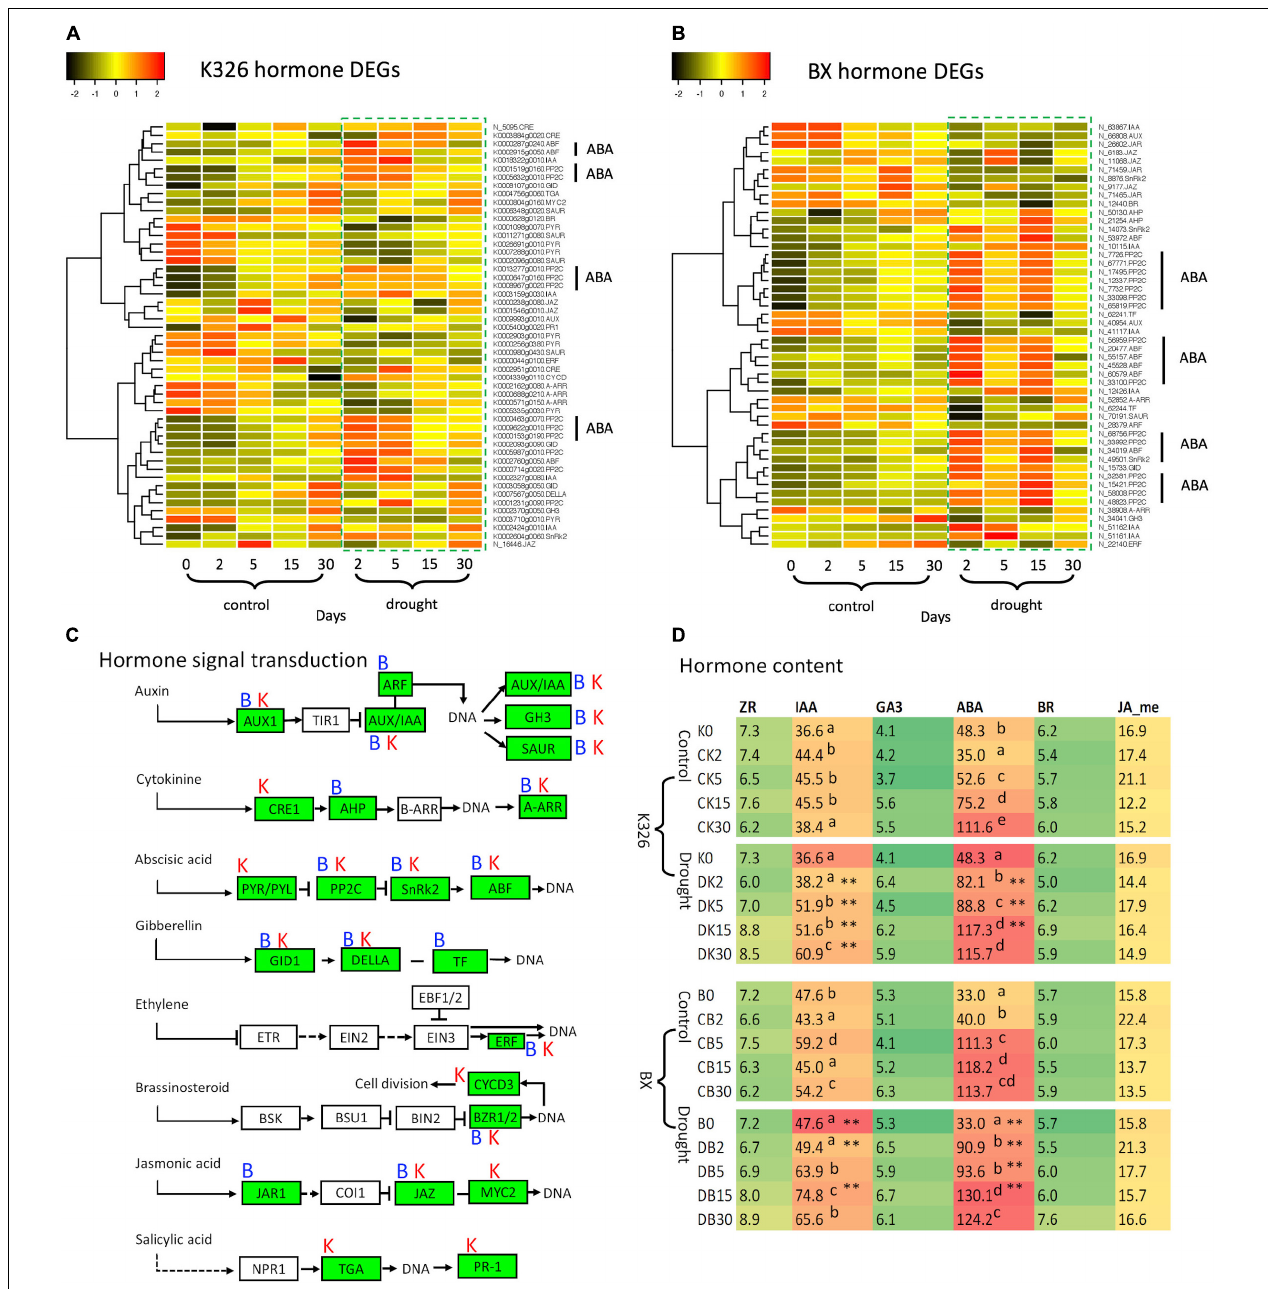
FIGURE 3 | Comparison of hormones and DEGs in hormone signaling pathways under drought stress. (A) Patterns of DEG expression level after log 2 (FPKM + 1) transformation and Z -score scaling in variety N. tabacum K326. (B) Patterns of DEG expression level after log 2 (FPKM + 1) transformation and Z -score scaling in variety N. tabacum BX. (C) Hormone signal transduction pathways, which were drawn based on the information of module ko04075 in the KEGG database (https://www.genome.jp/kegg, accessed on November 18, 2019); Letters “B” and “K” represent the DEG presence at BX and K326, respectively. (D) Abundances of six hormones. The hormone content was calculated as ng per gram of fresh leaves. Up script letters denote the significant differences from Duncan’s multiple range tests with p < 0.05. Asterisk ** represents significance at p < 0.05 and p < 0.01 between drought and control at the same time stage. AUX1, auxin influx carrier; AUX1/IAA, auxin-responsive protein IAA; ARF, auxin response factor; GH3, auxin responsive GH3 gene family; SAUR, SAUR family protein; CRE1, Arabidopsis histidine kinase 2/3/4; AHP, histidine-containing phosphotransferase; A-ARR, two-component response regulator ARR-A family; PYR/PYL, abscisic acid receptor PYR/PYL family; PP2C, clade A protein phosphatase 2C; SnRk2, serine/threonine-protein kinase domain SRK2 subgroup 3; ABF, ABA-responsive element binding factor; GID1, gibberellin receptor GID1; DELLA, DELLA protein; TF, phytochrome-interacting factor 4; ERF, ethylene-responsive transcription factor 1; BZR1/2, brassinosteroid resistant 1/2; CYCD3, cyclin D3; JAR1, jasmonic acid-amino synthetase; JAZ, jasmonate ZIM domain-containing protein; TGA, transcription factor TGA; PR-1, pathogenesis-related protein 1; ZR, zeatin riboside as a kind of cytokinin; IAA, indole-3-acetic acid; ABA, abscisic acid; BR, brassinosteroids; JA-me, methyl jasmonic acid. Expression data and hormone levels were obtained from three replicates, each with six biological plants at each stage.